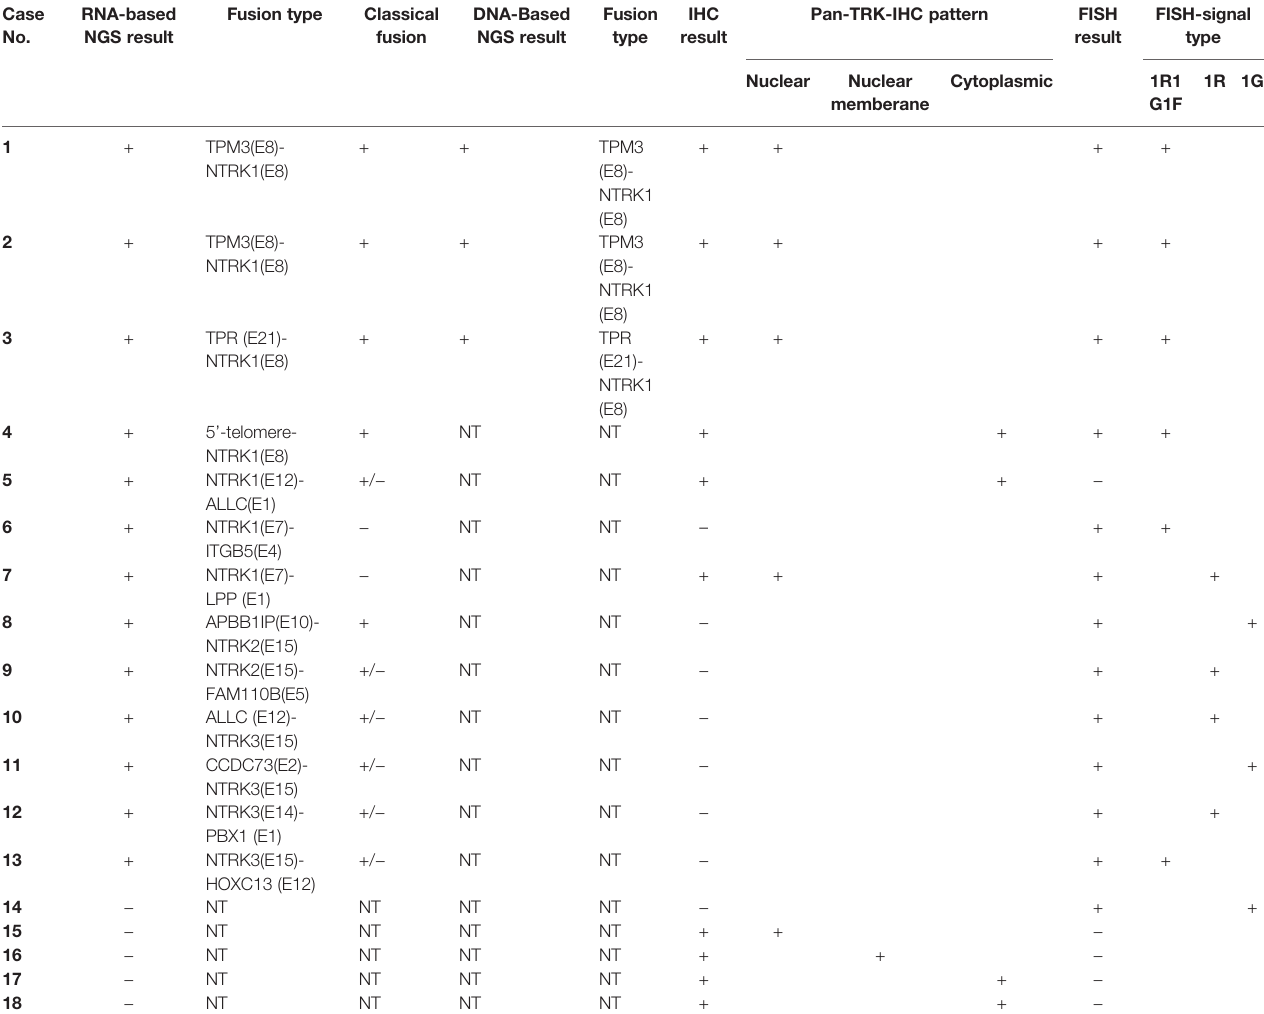
TABLE 1 | Immune and molecular characteristics of IHC, FISH or NGS NTKR fusion-positive cases. Case